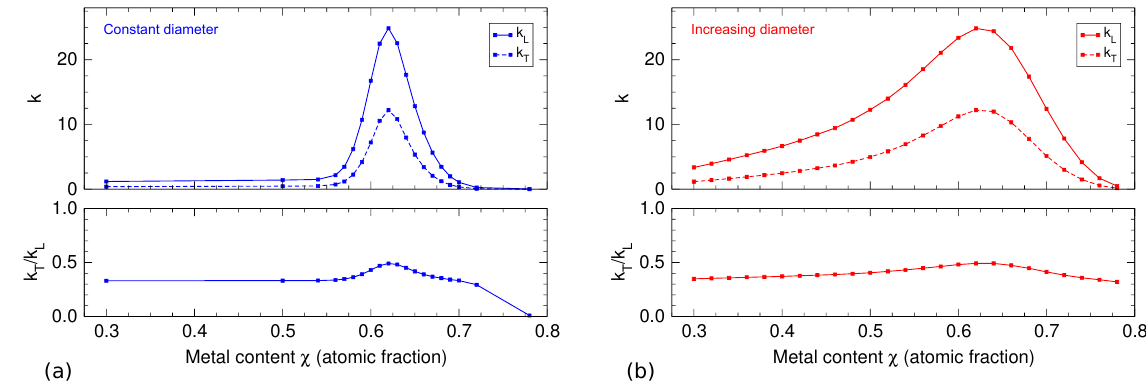
Figure 10. Gauge factors k L and k T over metal fraction for (a) constant and (b) increasing column diameter. With increasing diameters, the area of elevated gauge factors stretches across a wider range of metal